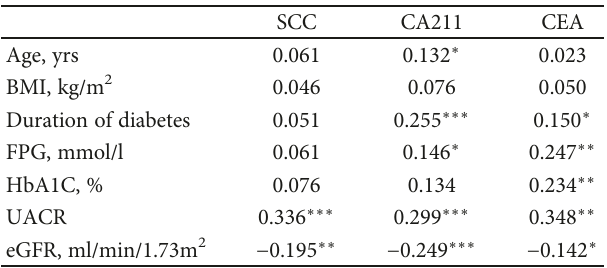
Figure 1: Positive rates of serum Cyfra21-1, SCC, CEA, and NSE levels in diabetic patients and healthy controls. DM: diabetes mellitus with normoalbuminuria; DN1: diabetes mellitus with microalbuminuria; DN2: diabetes mellitus with macroalbuminuria; SCC: squamous cell carninoma antigen; Cyfra21-1: cytokeratin 19 fragment antigen 21-1; NSE: neuron-speci fi c enolase; CEA: carcinoembryonic antigen. Table 3: Spearman correlation coe ffi cients between serum tumor markers and measured